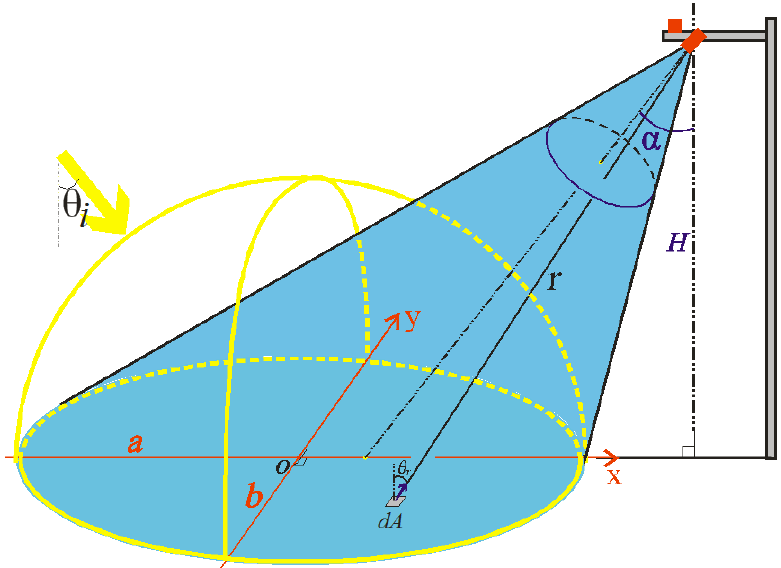
to the (cid:3045)